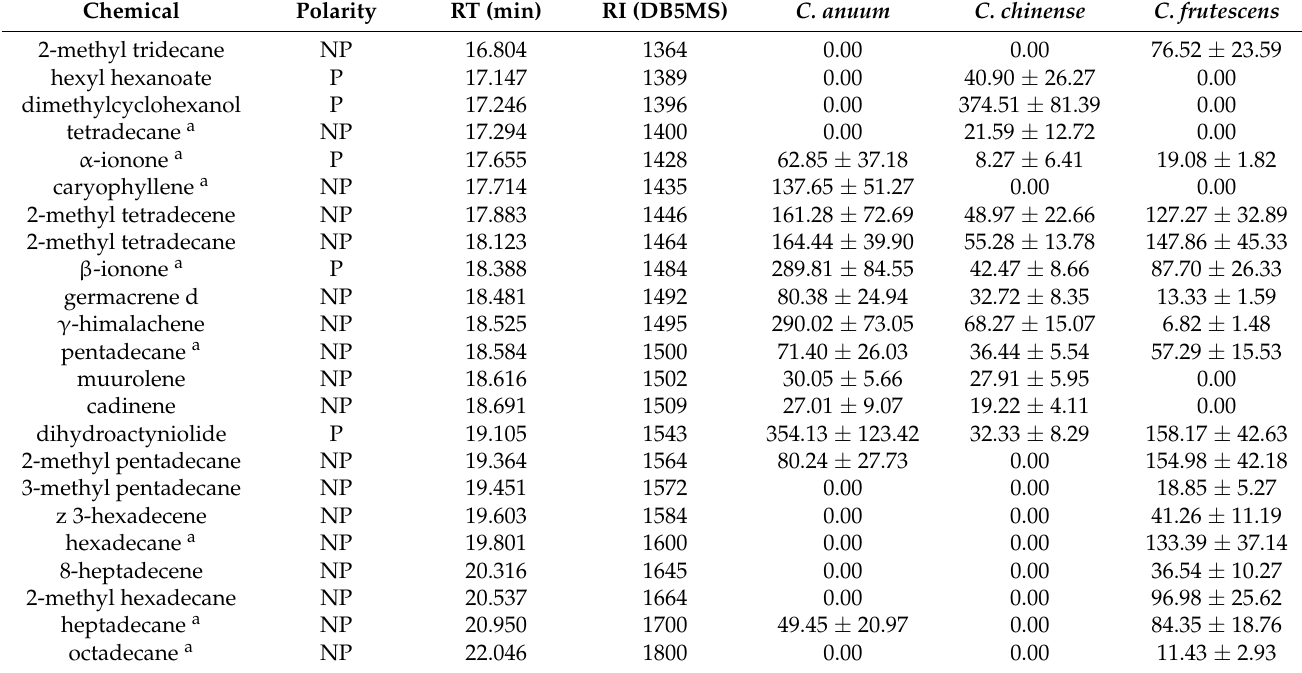
Table 1. Chemical composition of the VOC (ng) profile obtained from the HS-SPME air collection from the fruit powders of Capsicum annuum , C. chinense and C. frutescens Mean ( ± SE) emission rates are reported in ng, though comparison with 50 ng of nonadecane used as internal